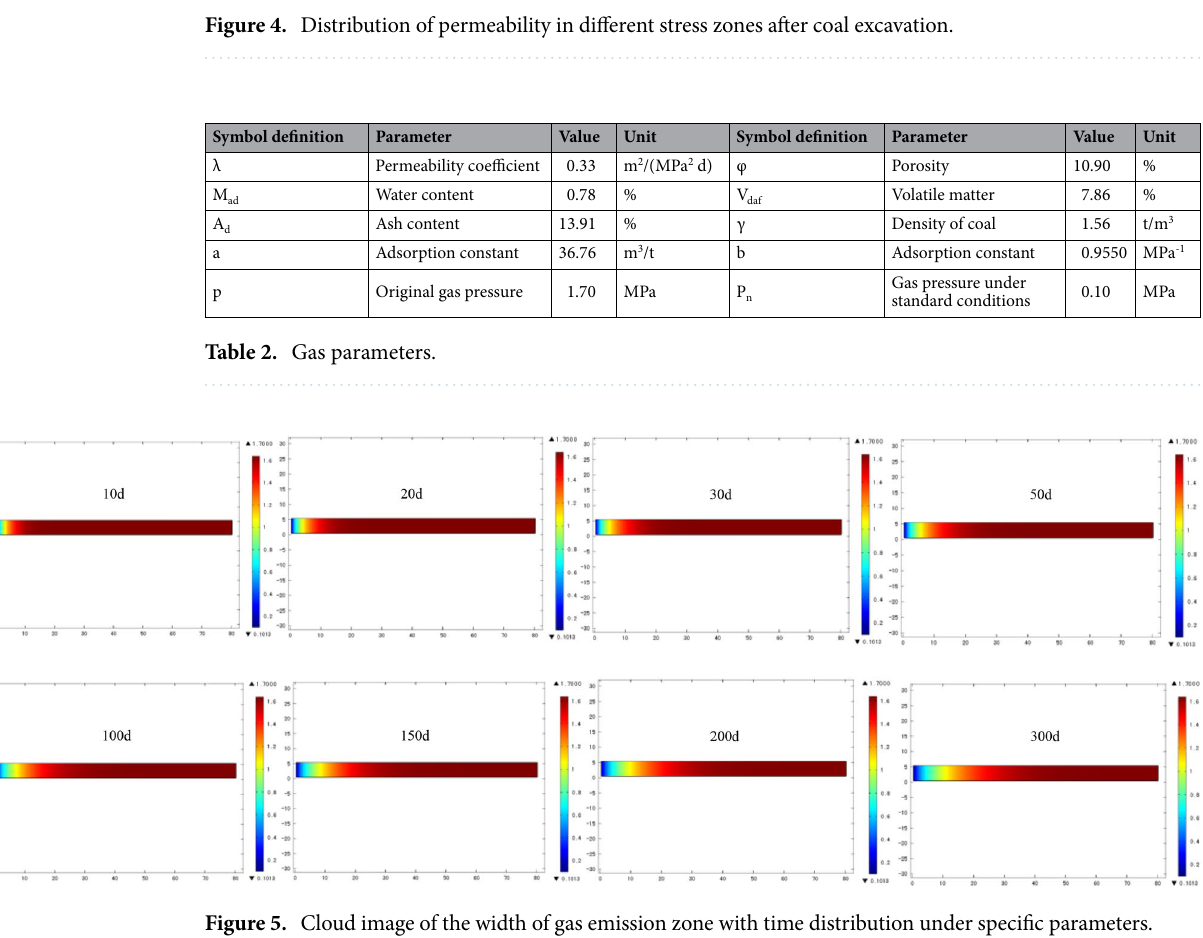
Figure 5. Cloud image of the width of gas emission zone with time distribution under specific